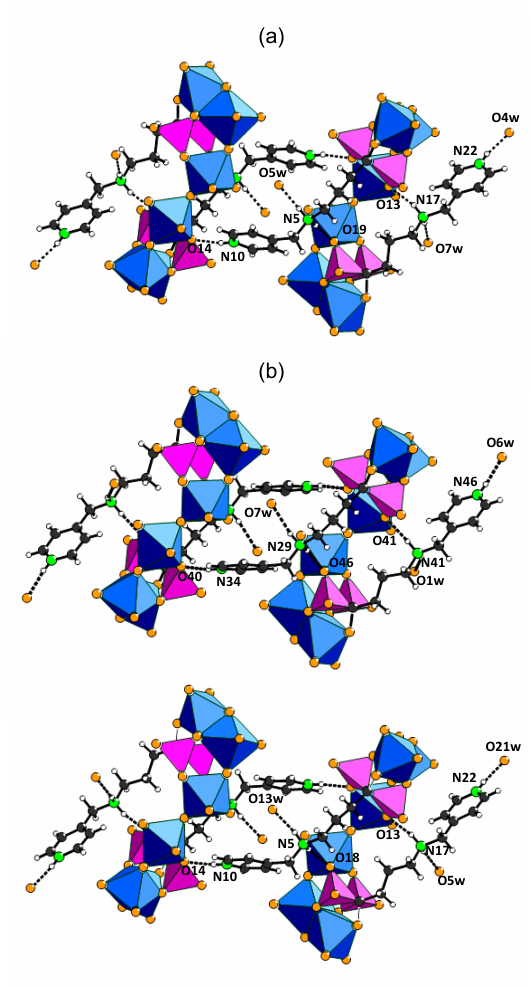
Figure 4. Hydrogen bonding schemes involving the supramolecular dimers {Mo 6 (Ale-